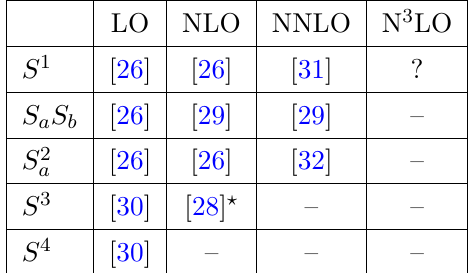
{ { { Table 1 . References we used to compare our results to 1PM parts of PN